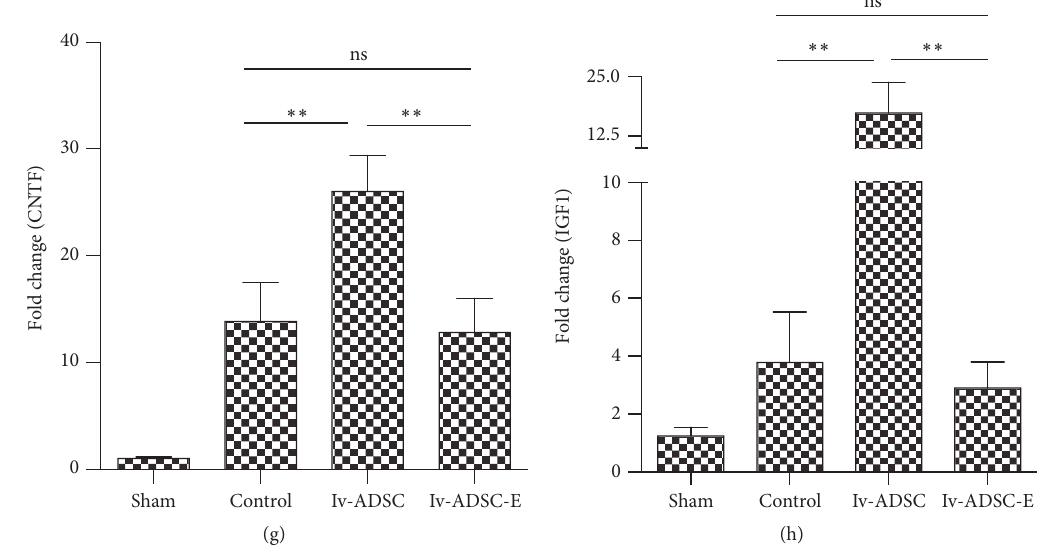
Figure 4: Different molecular signatures between ADSC and ADSC-E on stroke therapies. tMCAO was induced using SD rat. Either ADSC or ADSC-E was injected through IV. mRNA was extracted from the ipsolateral cortex. Cytokines (both pro- and anti-inflammatory) ((a)–(d), mRNA from Day 1) and neurotrophic factors ((e)–(h), mRNA from Day 3) were measured by real-time PCR ( 𝑛 = 6 /group). ANOVA was used to analyze the data. ∗ 𝑝 < 0.05 ; ∗∗ 𝑝 < 0.01